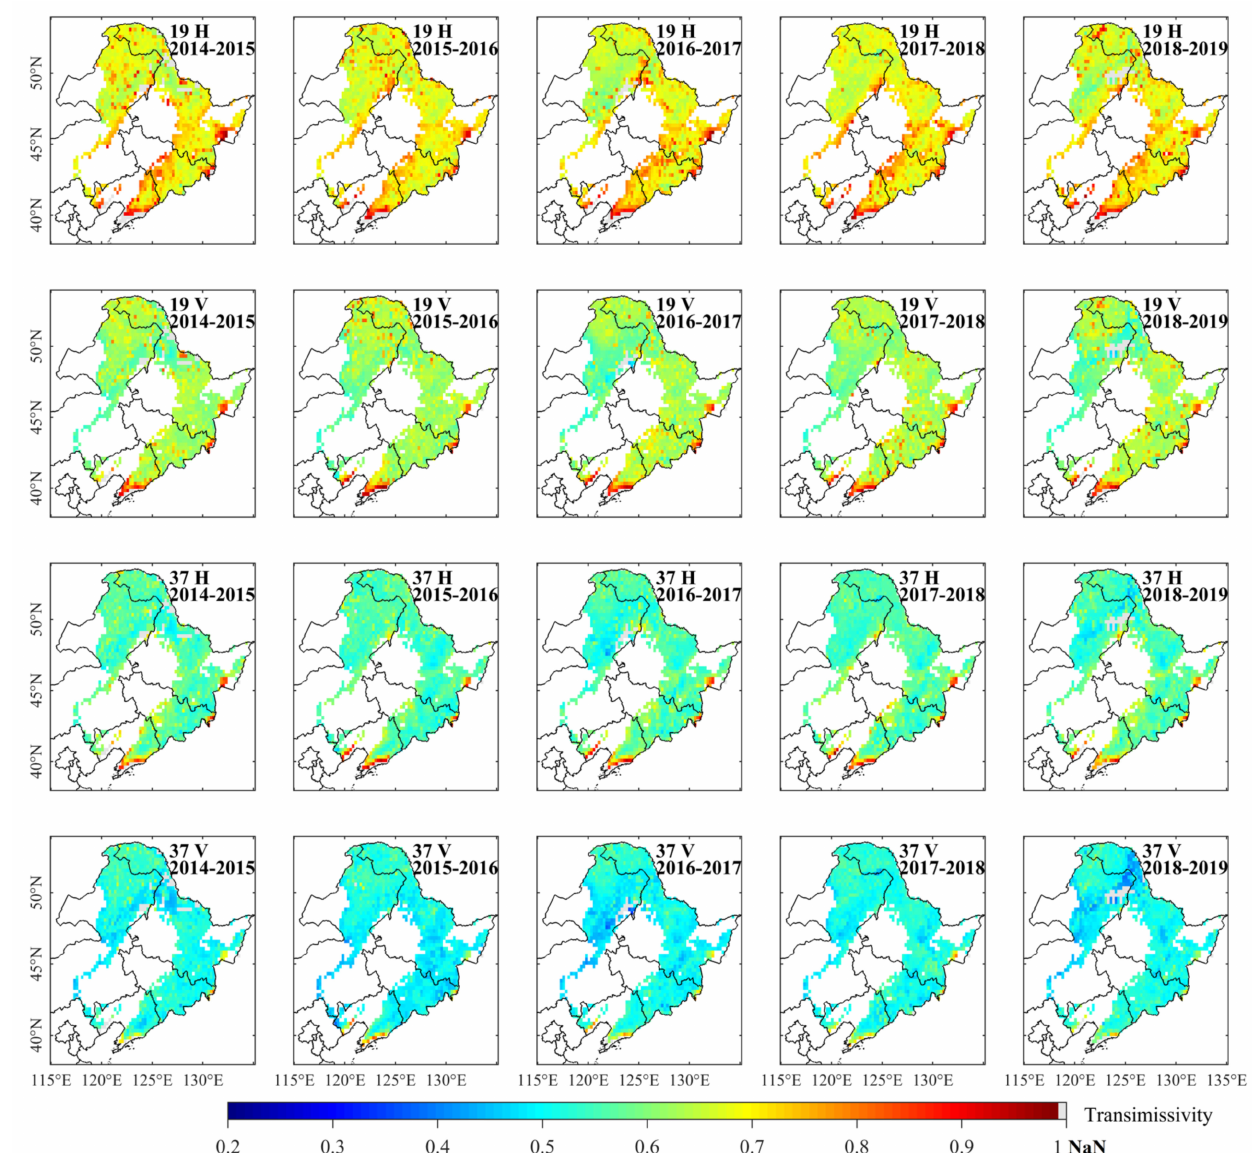
Figure 4. Estimation results of annual transmissivity under horizontal and vertical polarization at 19 GHz and 37